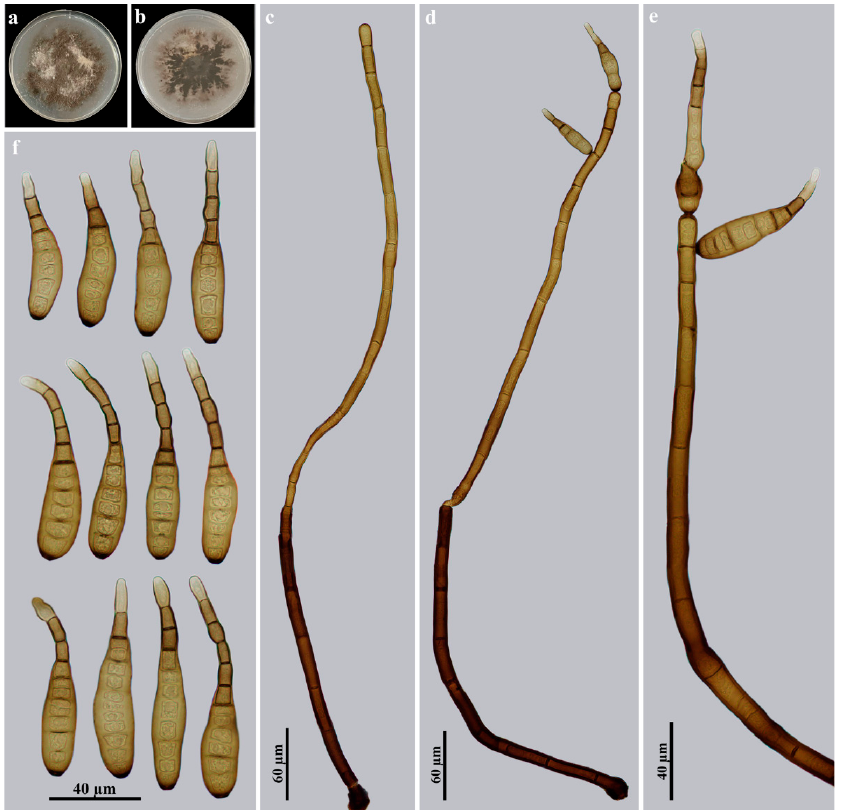
Figure 3. Helminthosporium jiulianshanense (HJAUP M1057, holotype): ( a ) surface of colony after 4 weeks on PDA; ( b ) reverse of colony after 4 weeks on PDA; ( c ) conidiophore and conidiogenous cells; ( d , e ) conidiophores, conidiogenous cells and conidia; ( f ) conidia.